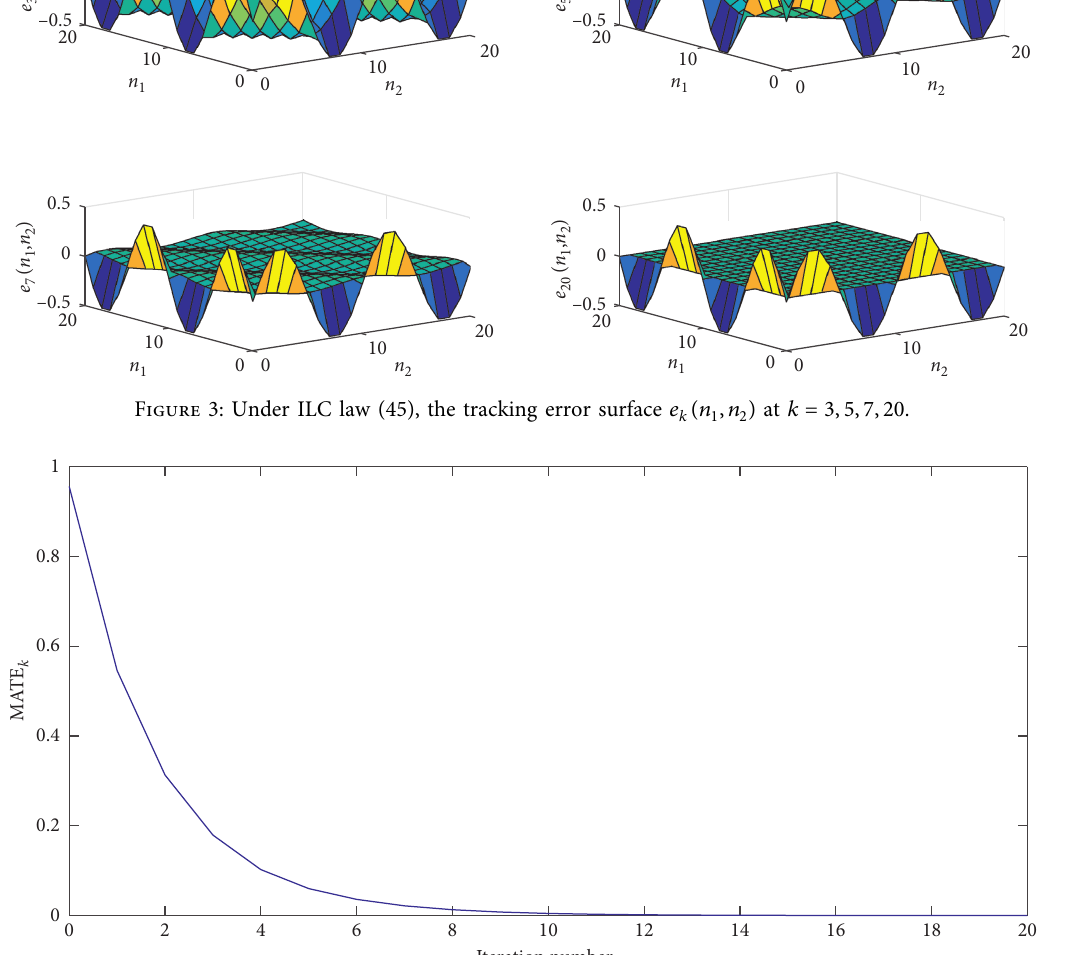
k k with iteration number